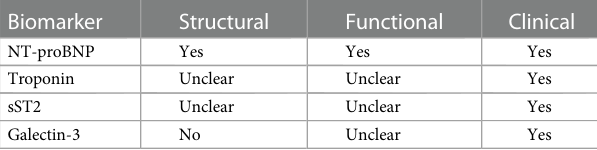
TABLE 2 Summary of the utility of biomarker monitoring to predict structural, functional, and clinical recovery in HF patients.